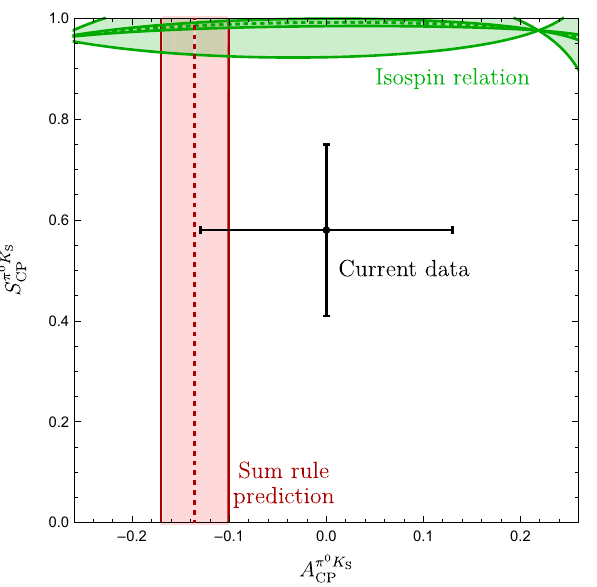
Fig. 8 Illustration of the B → π K puzzle: the upper green band fol- lows from the isospin analysis while the vertical band shows the sum rule prediction in Eq. (93)